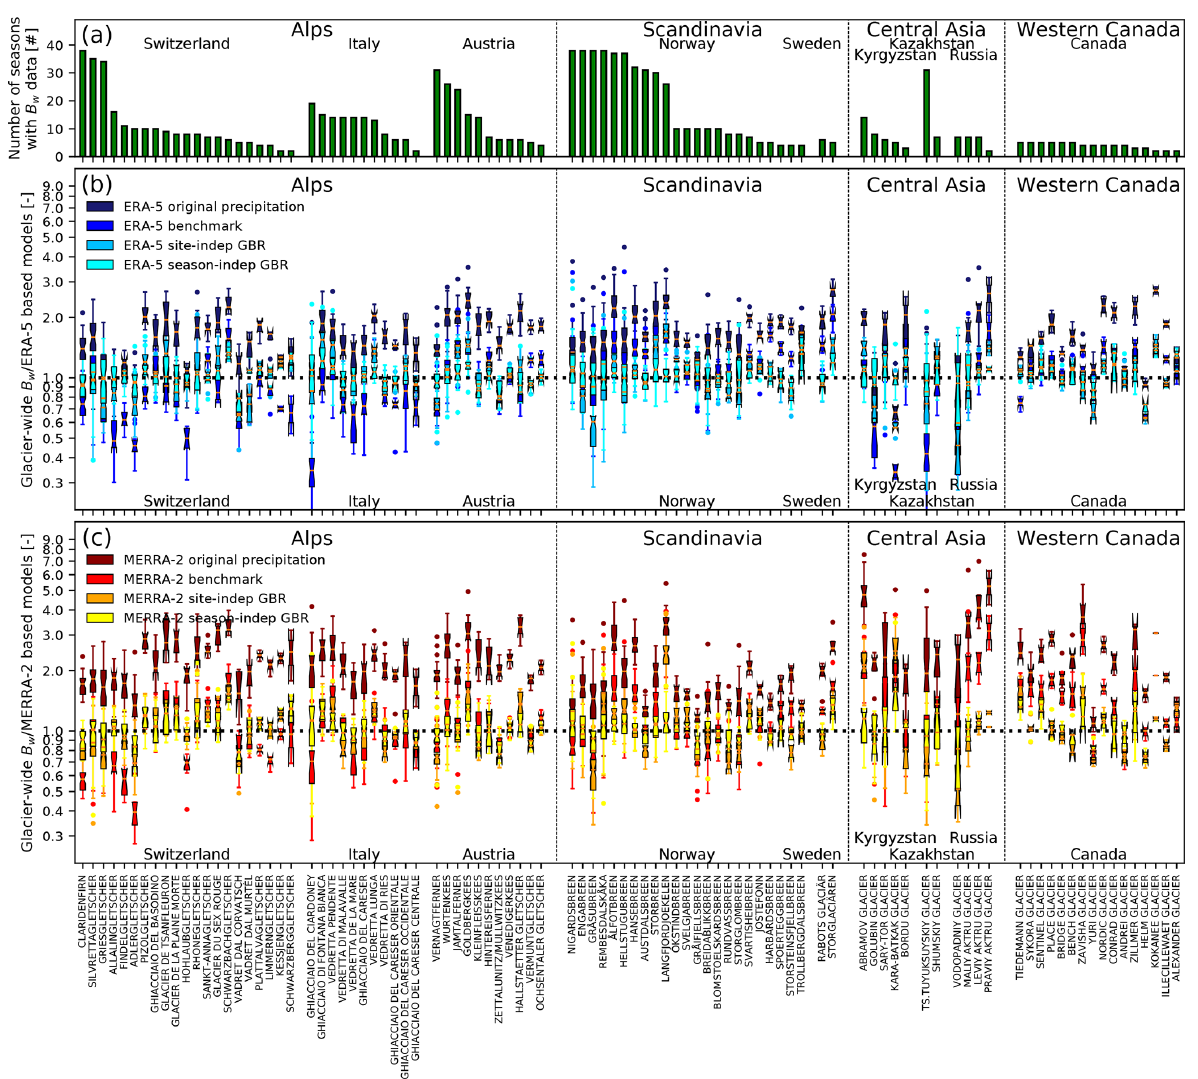
Figure 4. (a) Number of seasons with available B w data for each glacier. Factors between seasonal glacier-wide B w and (b) ERA5-based models and (c) MERRA-2 based models, for each glacier of the study. The variability shown in the boxplots is given by the different seasons of B w